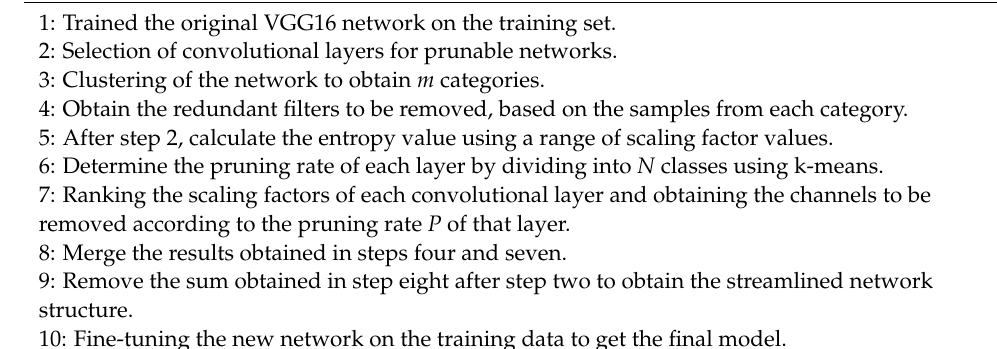
Algorithm 3 Fusion Pruning